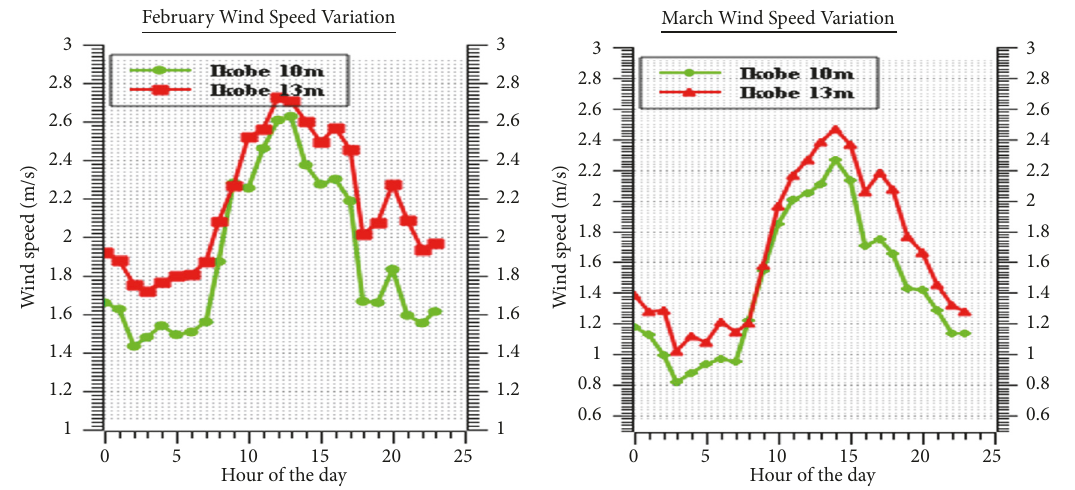
Figure 9: Ikobe site diurnal variation of wind speeds for months of February and March.